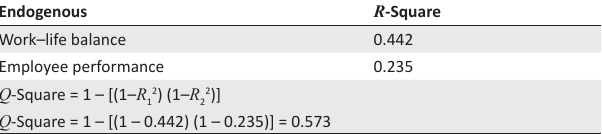
TABLE 6: Goodness-of-fit model results.